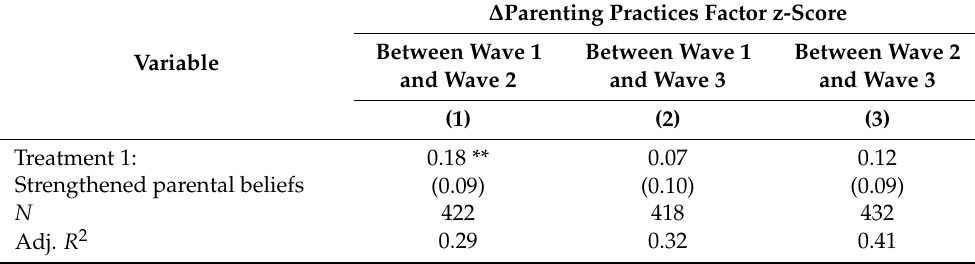
Table A1. DIDM analysis of the effect of strengthened and weakened parental beliefs on parent- ing